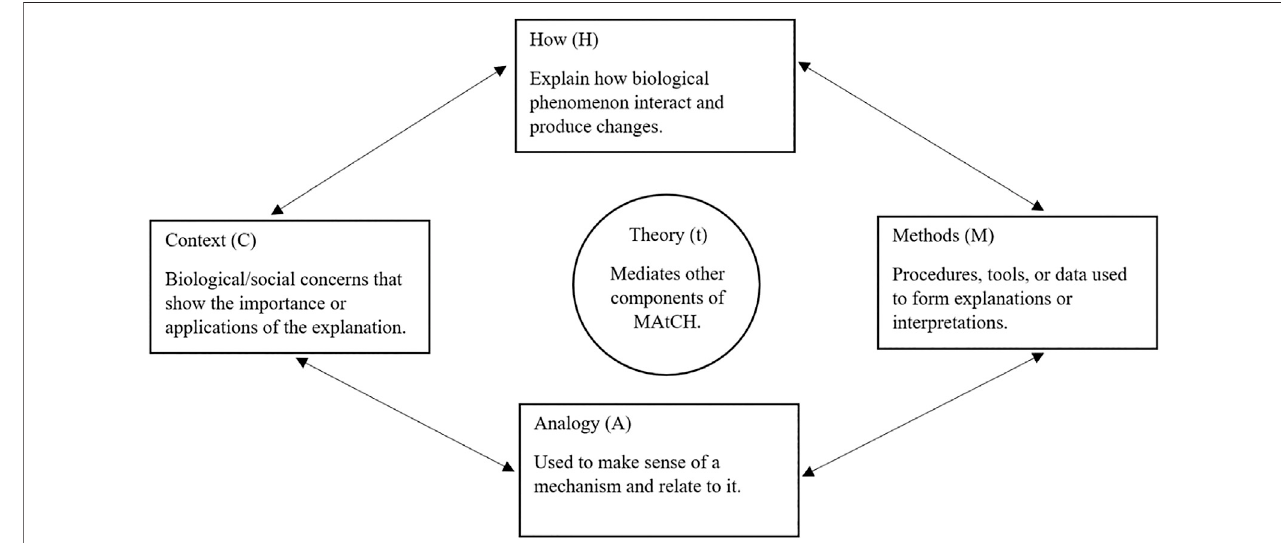
FIGURE 1 | Diagram of the MAtCH